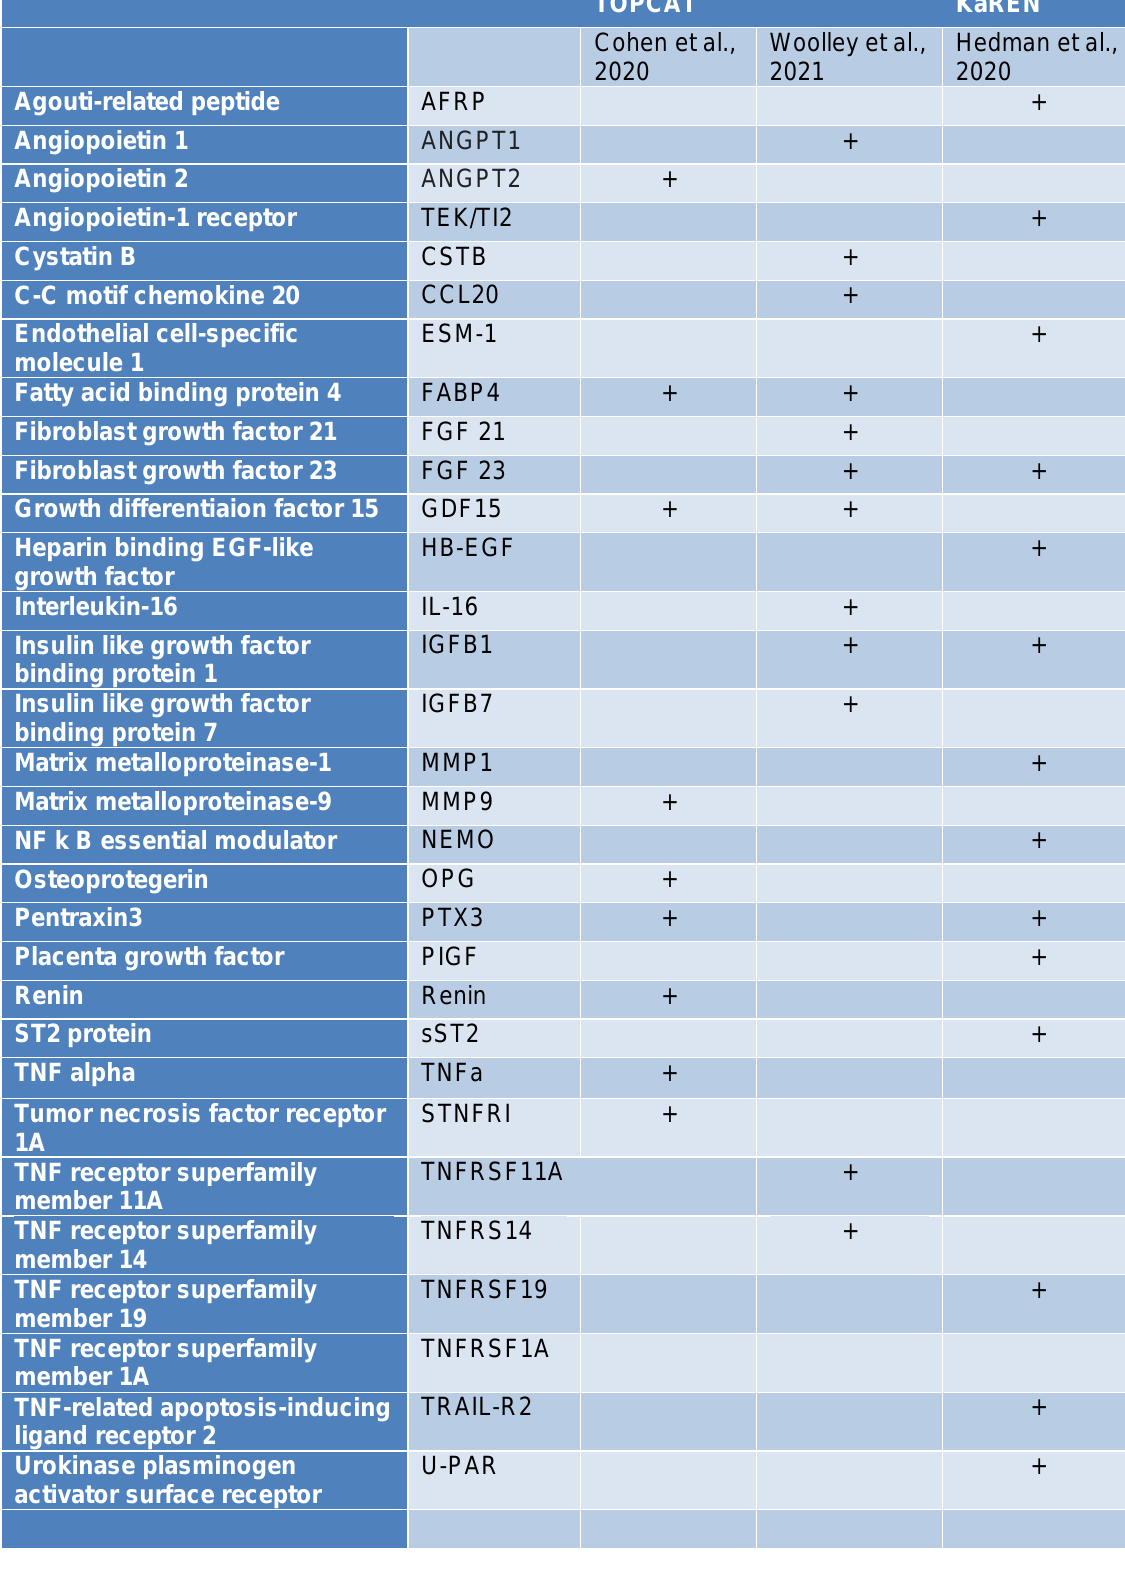
Table 3: Some biomarkers associated with worst outcome in HFpEF